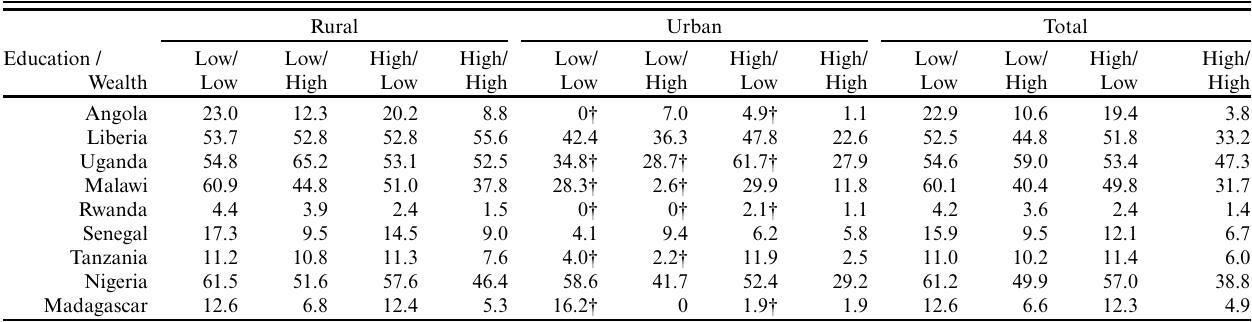
Table 4 . Malaria parasitemia (%) by any/no maternal education and above/below median wealth, stratified by urban residence. Rural Urban Total Education / Low/ Low/ High/ High/ Low/ Low/ High/ High/ Low/ Low/ Low High Low High Angola 23.0